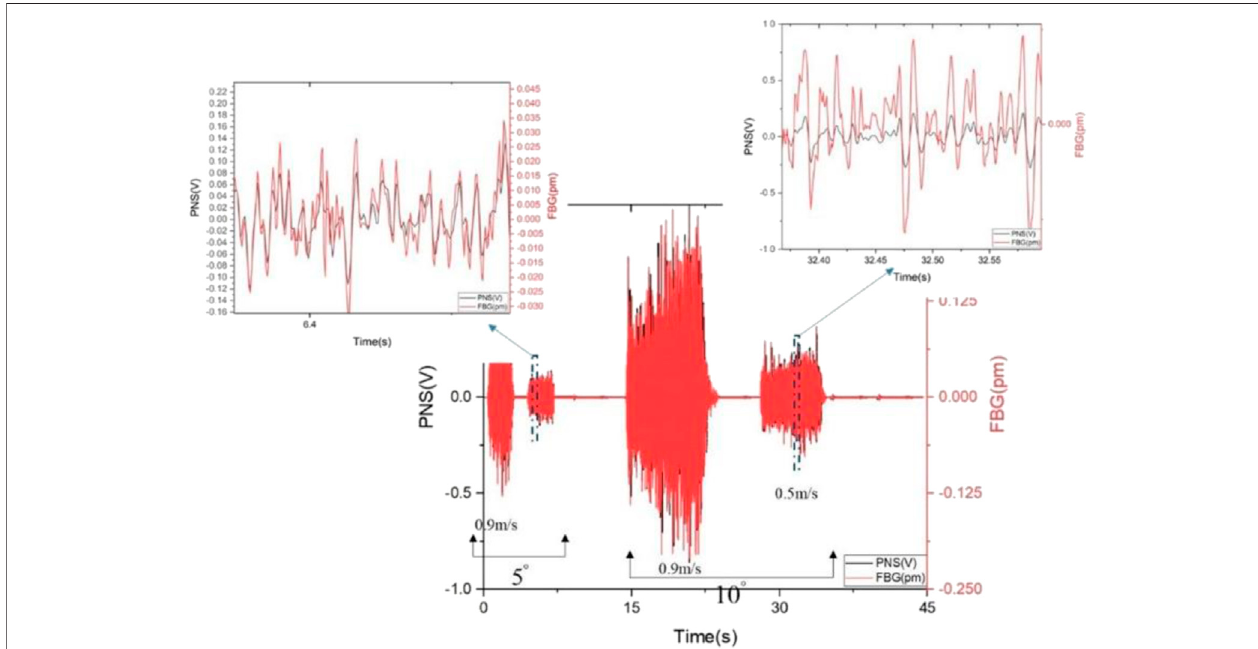
FIGURE 15 | Correlation comparison chart - PNS signal vs FBG signal